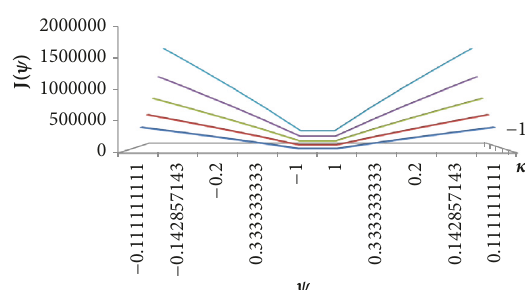
Figure 8: Graph of expected present value of the utility of asset 𝐽(𝜓) versus control 𝜓 and consumption level 𝜇 while subjective discount rate 𝜂 and degree of relative risk 𝜆 are fixed at 0.1 and 0.9 ,